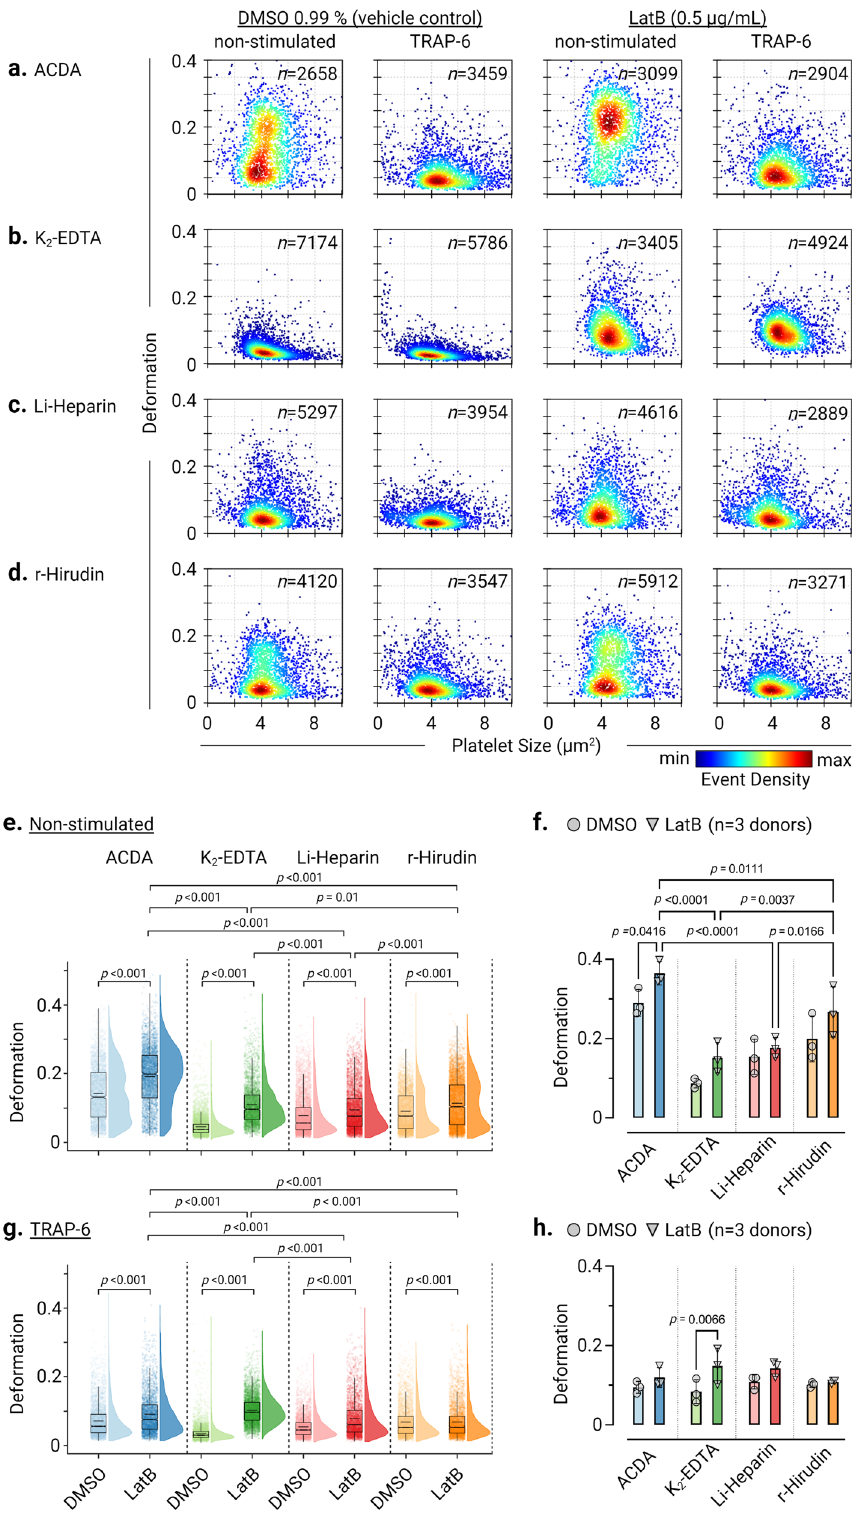
Fig. 6 Inhibition of actin polymerization by LatB strongly affects platelet deformation. KDE scatter plots showing the impact of LatB on single platelet deformation and size on non-stimulated (resting) platelets and after TRAP-6 stimulation compared to the vehicle control (DMSO 0.99 %) in a ACD-A, b K 2 -EDTA, c Li-Heparin and in d r-Hirudin (n = number of single platelets). Statistical distribution plots for platelet deformation from non-stimulated platelets ( e ) and ( f ) after TRAP-6 stimulation ( g ) and ( h ). Notch in the box plot and the horizontal line depicts median and mean, respectively, and the interquartile ranges. The full distribution of the data for each parameter is depicted by half-violin plots and staggered dots. (Individual data points in ( f ) and ( h ) show median values of platelet deformation from n = 3 donors). Statistical assessment by Kruskal-Wallis-Test followed by Dunn ’ s multiple comparisons test and repeated measures one-way ANOVA followed by Tukey ’ s multiple comparisons test. p < 0.05 was considered signi fi